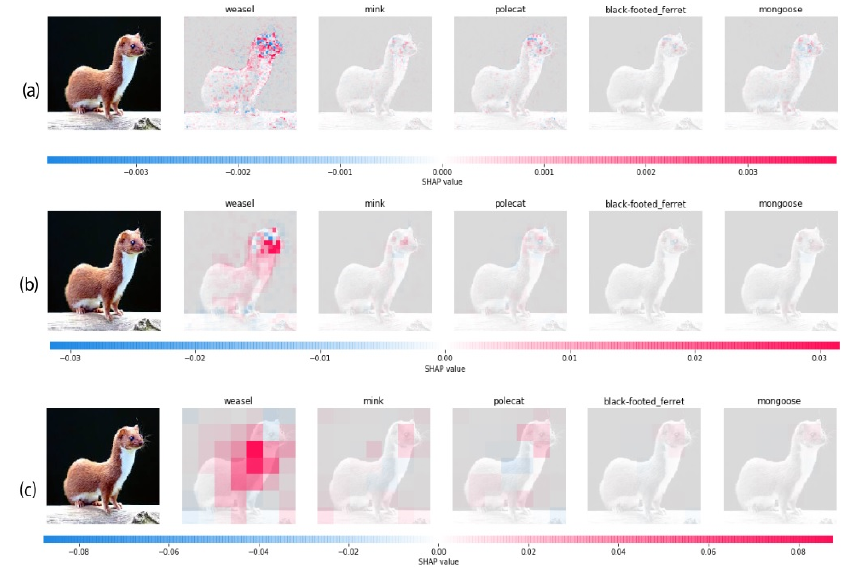
Figure 3. Analyzing the network decision using Shapley-value-based interpretations in the VR environment. These interpretations are shown for three hidden layers namely conv1, conv3, and conv5, respectively (see also Figure 4 for zoomed in view).